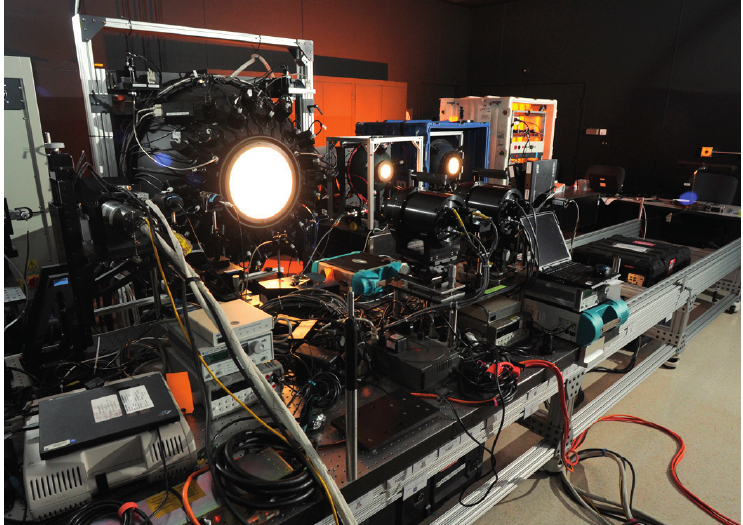
Figure 12. The radiometers and spheres used in the radiometric round robin calibration